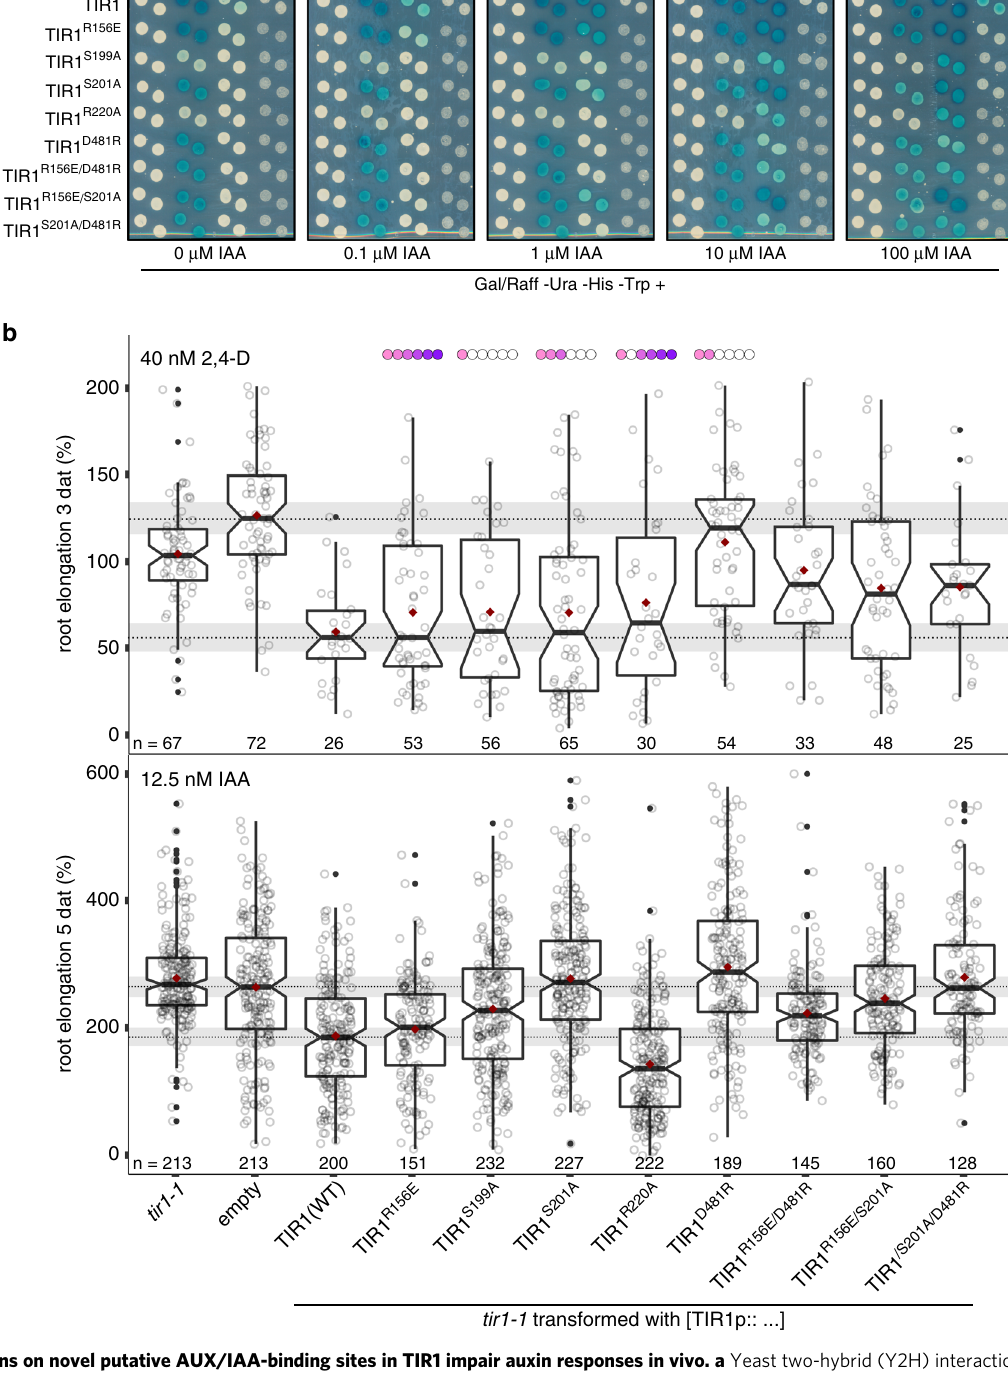
Fig. 7 Mutations on novel putative AUX/IAA-binding sites in TIR1 impair auxin responses in vivo. a Yeast two-hybrid (Y2H) interaction matrix for TIR1 wild type and TIR1-mutant versions carrying amino acid exchanges on relevant CAS-identi fi ed residues with ASK1, IAA7 and IAA12 at different auxin concentrations. b Box plots depicting root length of T1 tir1-1 mutant plants carrying TIR1p: tir1 mutant constructs. Transformed T1 seeds expressing RFP were selected by microscopy, and germinated in growth media. Five-day-old seedlings were transferred to growth medium containing either 40 nM 2,4- D or 12.5 nM IAA. Root elongation was traced on the day of transfer, and at days 3 and 5 after auxin treatment. tir1-1 mutants are resistant to auxin treatment exhibiting long roots, and auxin sensitivity in tir1-1 is restored by introducing a construct expressing wild type TIR1 under its own promoter. Numbers below the boxes correspond to the number of independent T1s (open circle ’ s) analyzed per construct. Solid black horizontal lines represent median, dark red dots mean values and whiskers correspond to the upper and lower ~25% (1.5*IQR) of the data points. Outliers are shown as solid black dots. Shadow rectangles represent the notch size (~95% con fi dence interval) of the two reference data sets (empty vector and TIR1 wild type). Conservation of mutated residues in the TIR1/AFB1-5 F-box subclade is depicted as gradient colored circles above the plots (TIR1: light pink, AFB1-4: gradient of darker pink, AFB5: deep